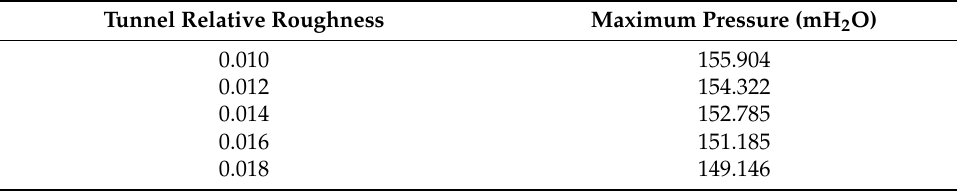
Table 3. Maximum pressure in the tailrace tunnel with different relative roughnesses.